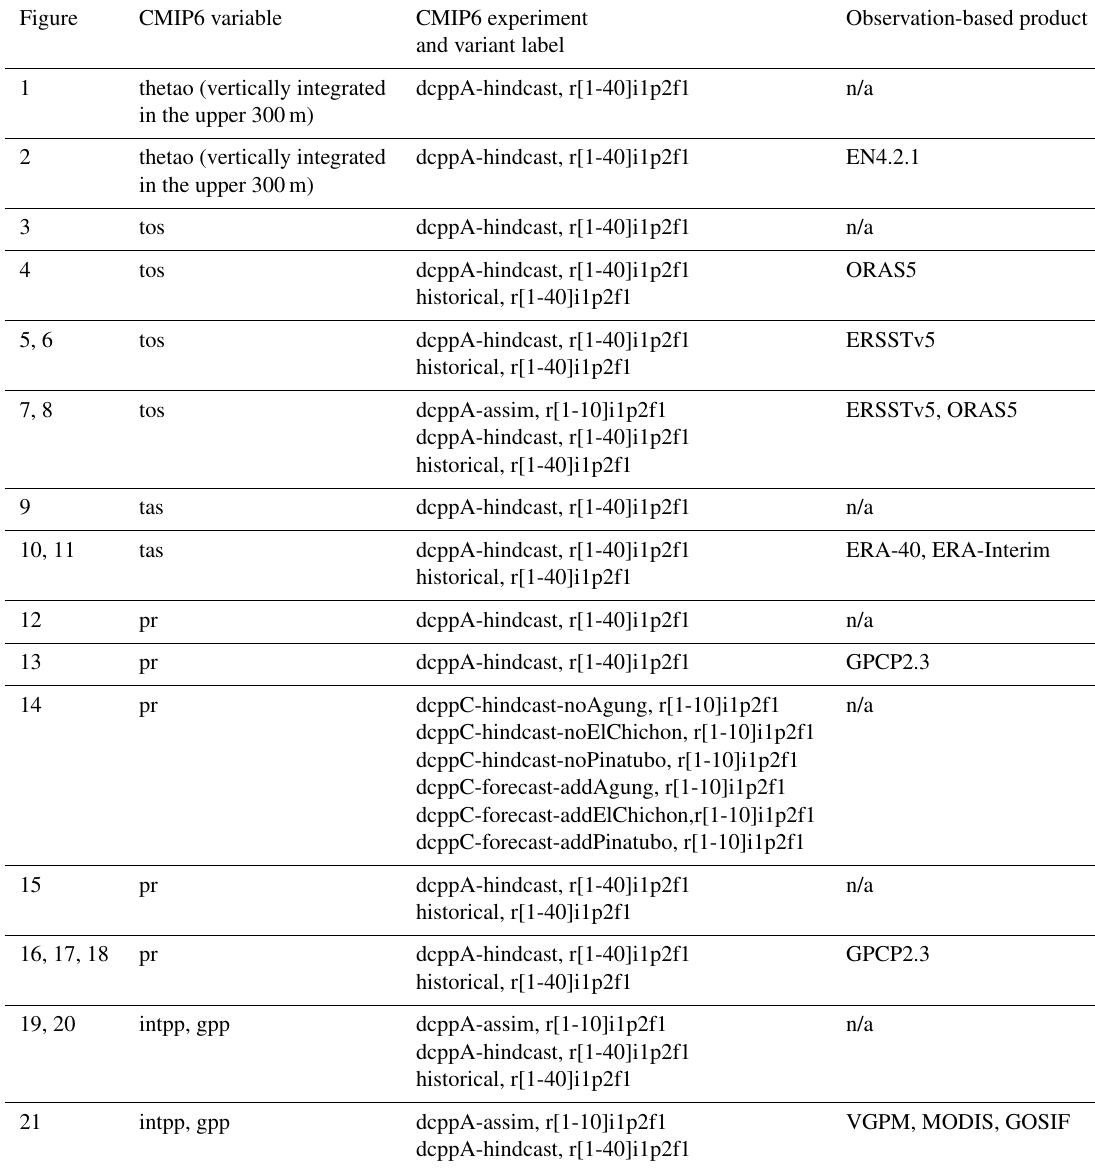
Table B1. List of figures, CMIP6 variables, experiments, and verifying observation-based products employed in this paper. See Table B2 for the sources of the observation-based products. The entry “n/a” indicates “not